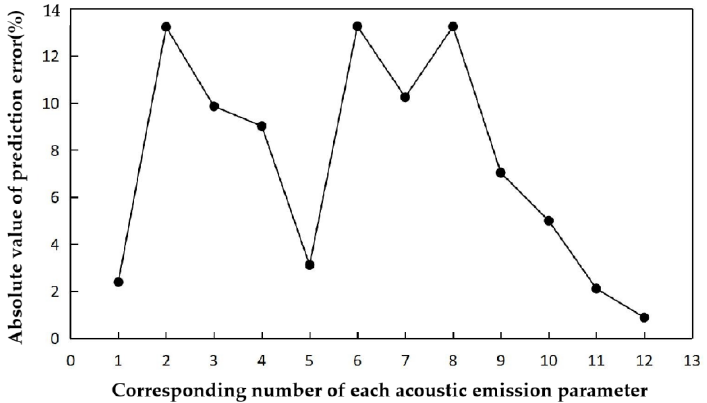
Figure 19. Single parameter (1–10), rise-time–amplitude (11), and multiparameter (12) absolute value of prediction